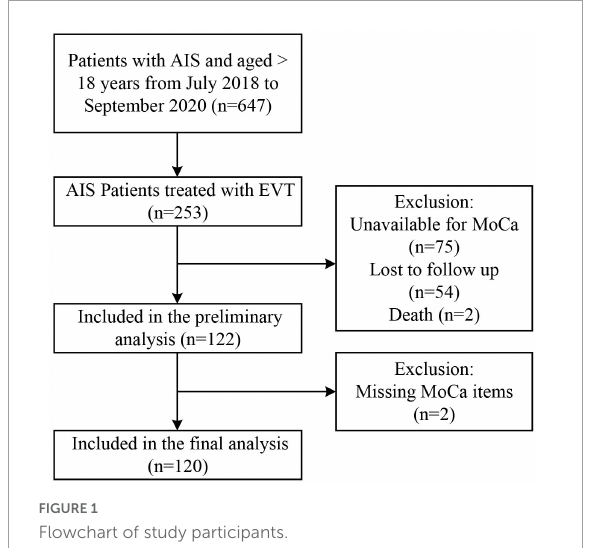
FIGURE1 Flowchart of study participants.